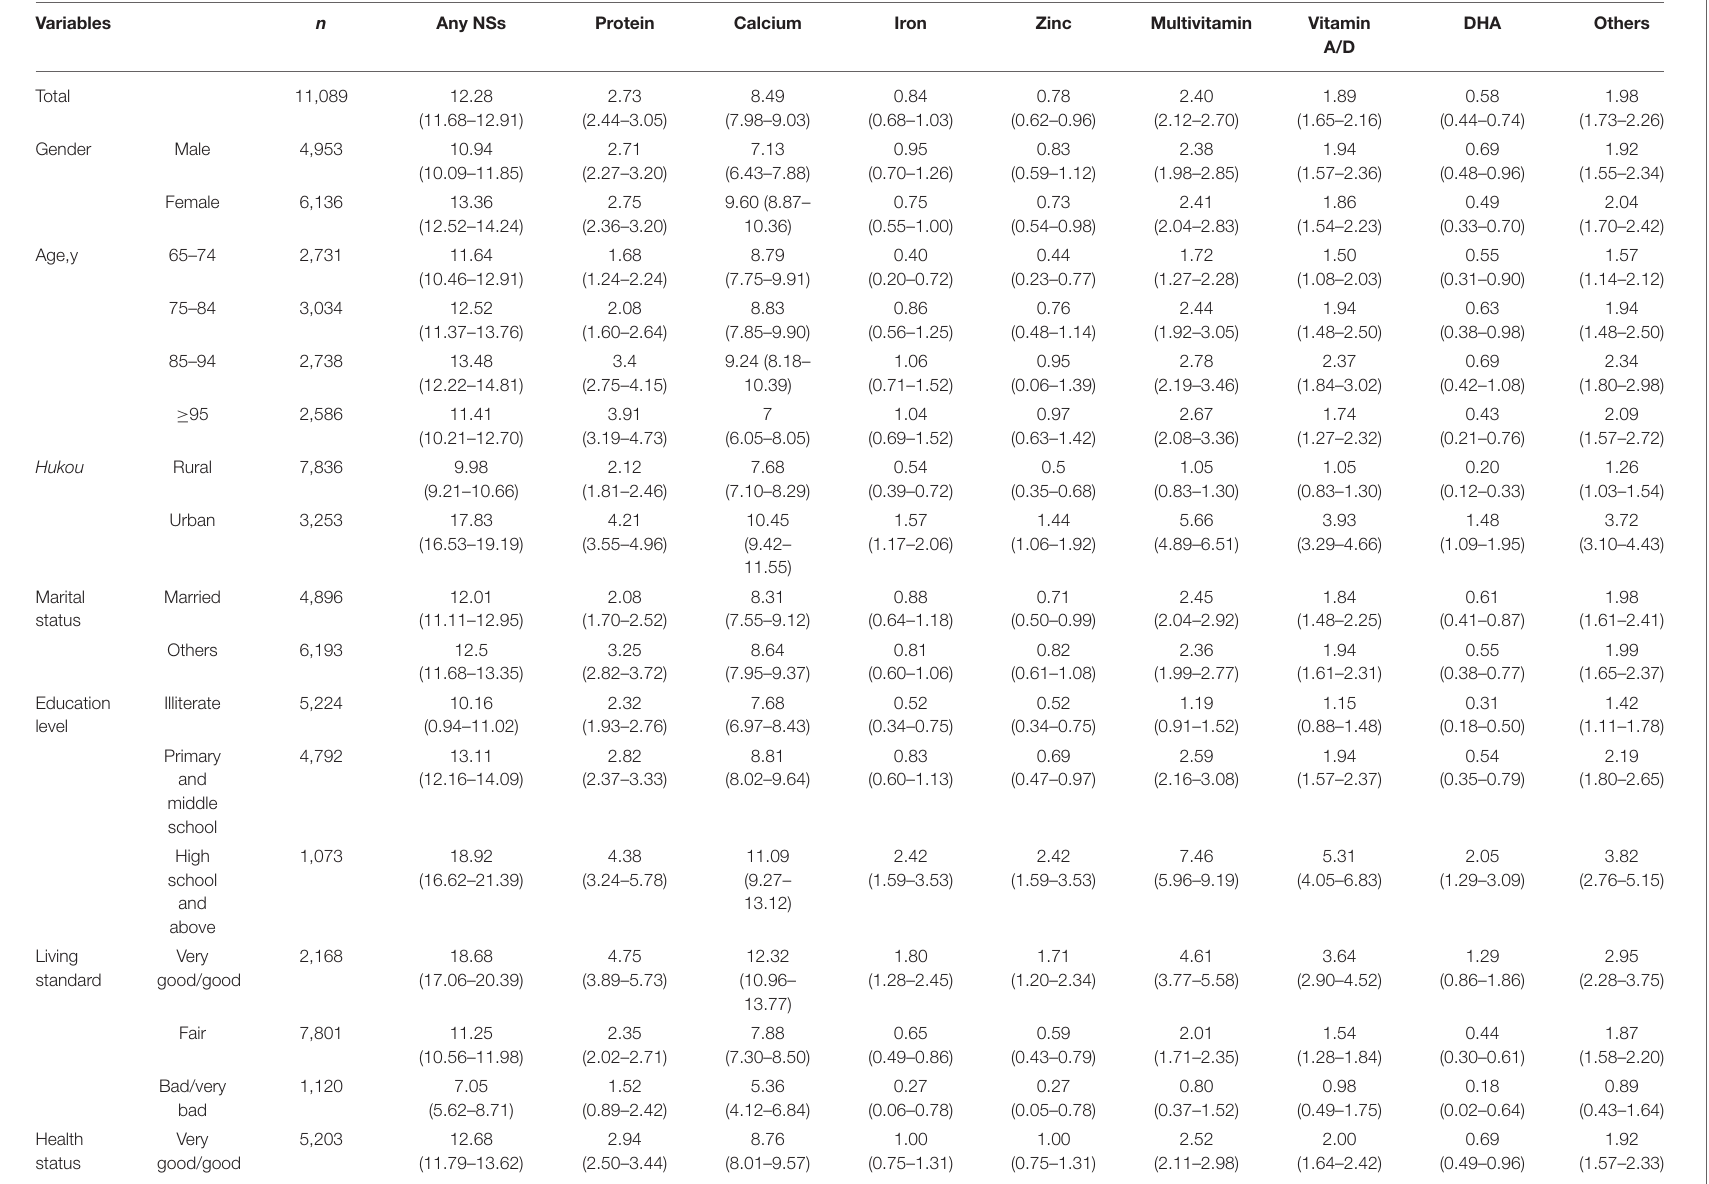
TABLE 1 | Prevalence (%, 95% confidence interval) and types of NSs used by older